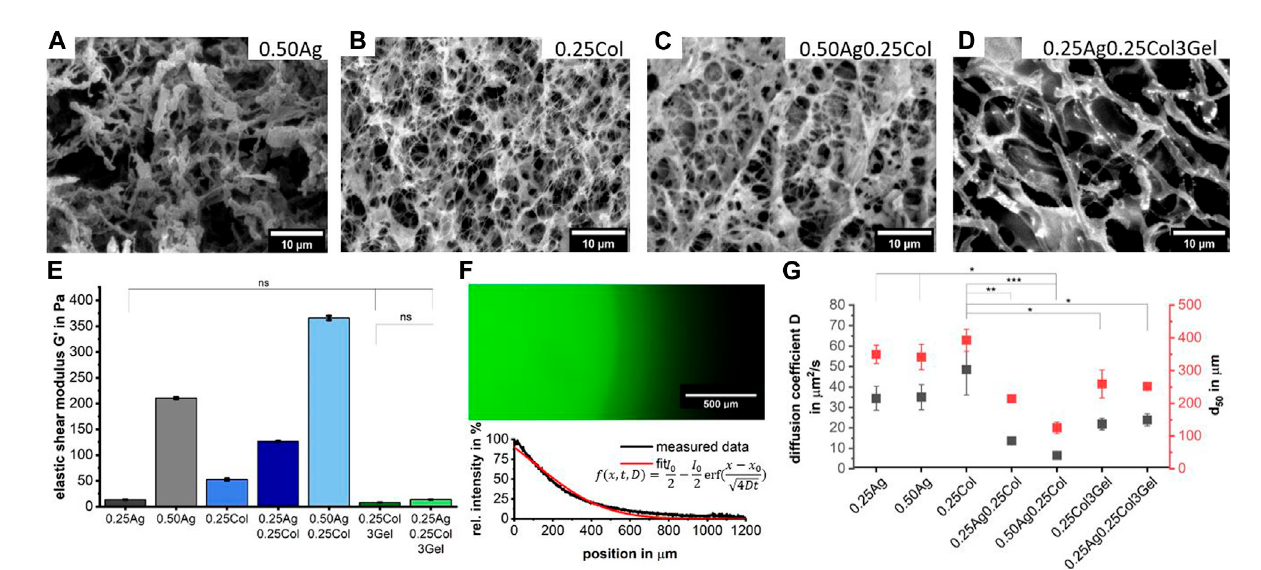
FIGURE 2 SEM images show the microstructure of 0.50Ag (A) , 0.25Col (B) , 0.50Ag0.25Col (C) and 0.25Ag0.25Col3Gel (D) . The elastic component of the shear modulus G ′ for all seven materials as measured in a rotational rheometer; p < 0.001 except when stated otherwise; n = 3 (E) . The diffusion of FITC-labelled bovine serum albumin was determined using Fick ’ s second law of diffusion on fl uorescence intensity pro fi les after 30 min of incubation as shown for 0.50Ag (F) .Fromthesepro fi les,thediffusioncoef fi cient D andthedistanceuntil50%signalintensityremained d 50 weredetermined; p < 0.001for D unlessstated otherwise; d 50 was found unsigni fi cant; n = 3 (G)